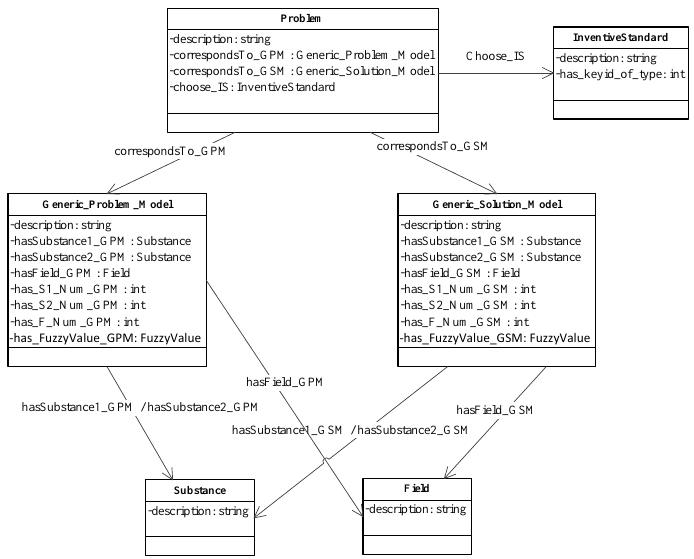
Figure 3. The framework of the Su-Field analysis